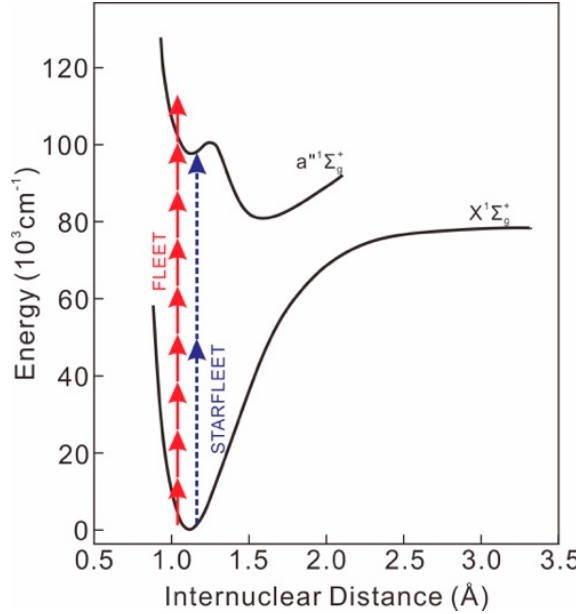
Figure 8. The nitrogen excitation strategy of FLEET and selective two-photon absorptive resonance FLEET (STARFLEET).